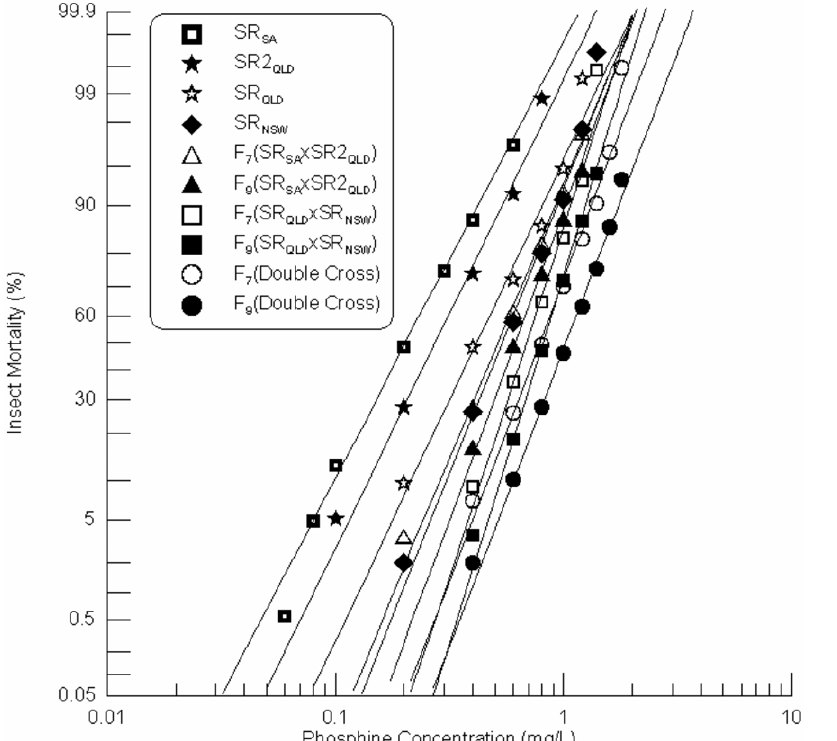
Figure 9. Resistance response of selected F 7 and F 9 progenies of double crosses between the strong resistant R.dominica strains from Australia. Results are presented as log-dose mortality of the F 7 and the F 9 progenies with reference curves of the F 7 and F 9 progenies the single crosses, SR QLD 6 SR NSW and SR SA 6 SR2 QLD , and the parental strains, SR QLD , SR2 QLD , SR NSW and SRSA. Phosphine exposure was for 48 hours at 25 u C and 70% r.h.